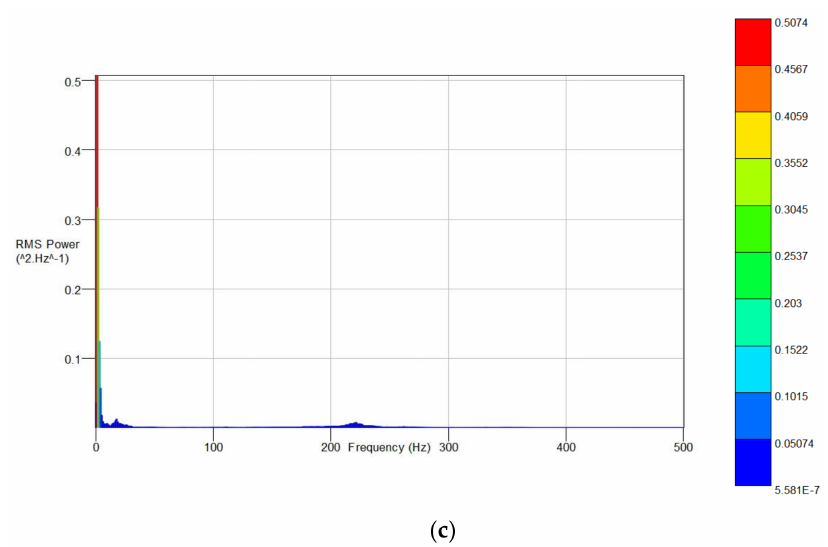
Figure 7. Power spectra density (PSD) of acceleration signals for different roads: ( a ) highway; ( b ) residential; and, ( c )